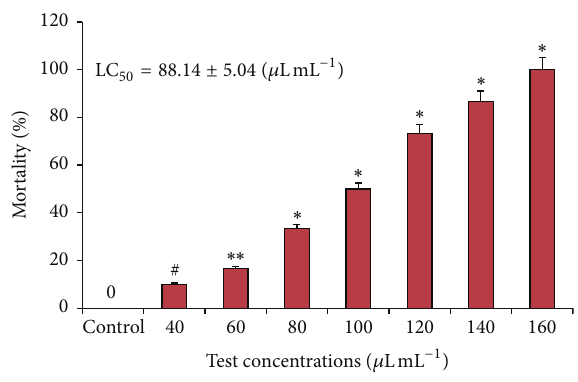
Figure 7: Cytotoxicity of Ag NPs on Artemia salina : increased concentration of Ag NPs (0–160 𝜇 L/mL) ( 𝑋 -axis) mortality of the larvae up to 100% ( 𝑌 -axis); all the data were expressed in mean ± SD of three replicates. ∗ 𝑃 < 0.0001 and ∗∗ 𝑃 < 0.01 indicate statistical significance; # NS (not